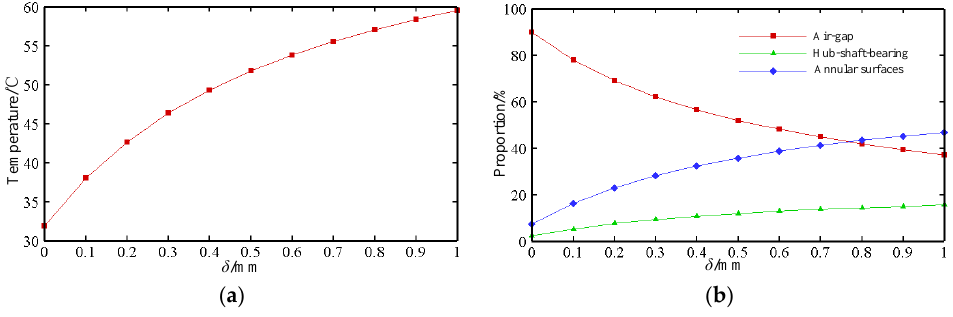
Figure 9. Influence of δ on cooling performance: ( a ) relationship diagram of δ and average winding temperature; ( b ) relationship diagram of δ and proportion of HTR of each cooling path.